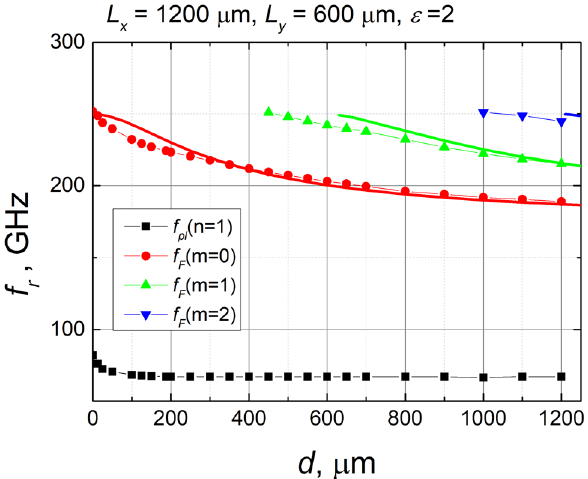
Figure 5. Dependences of resonance frequencies on the thickness of the substrate. Points show results extracted from the calculated transmittance spectrum. Squares correspond to the first plasmonic resonance, and other points show Fano resonance frequencies. Solid lines demonstrate frequencies of waveguide modes excited in a dielectric